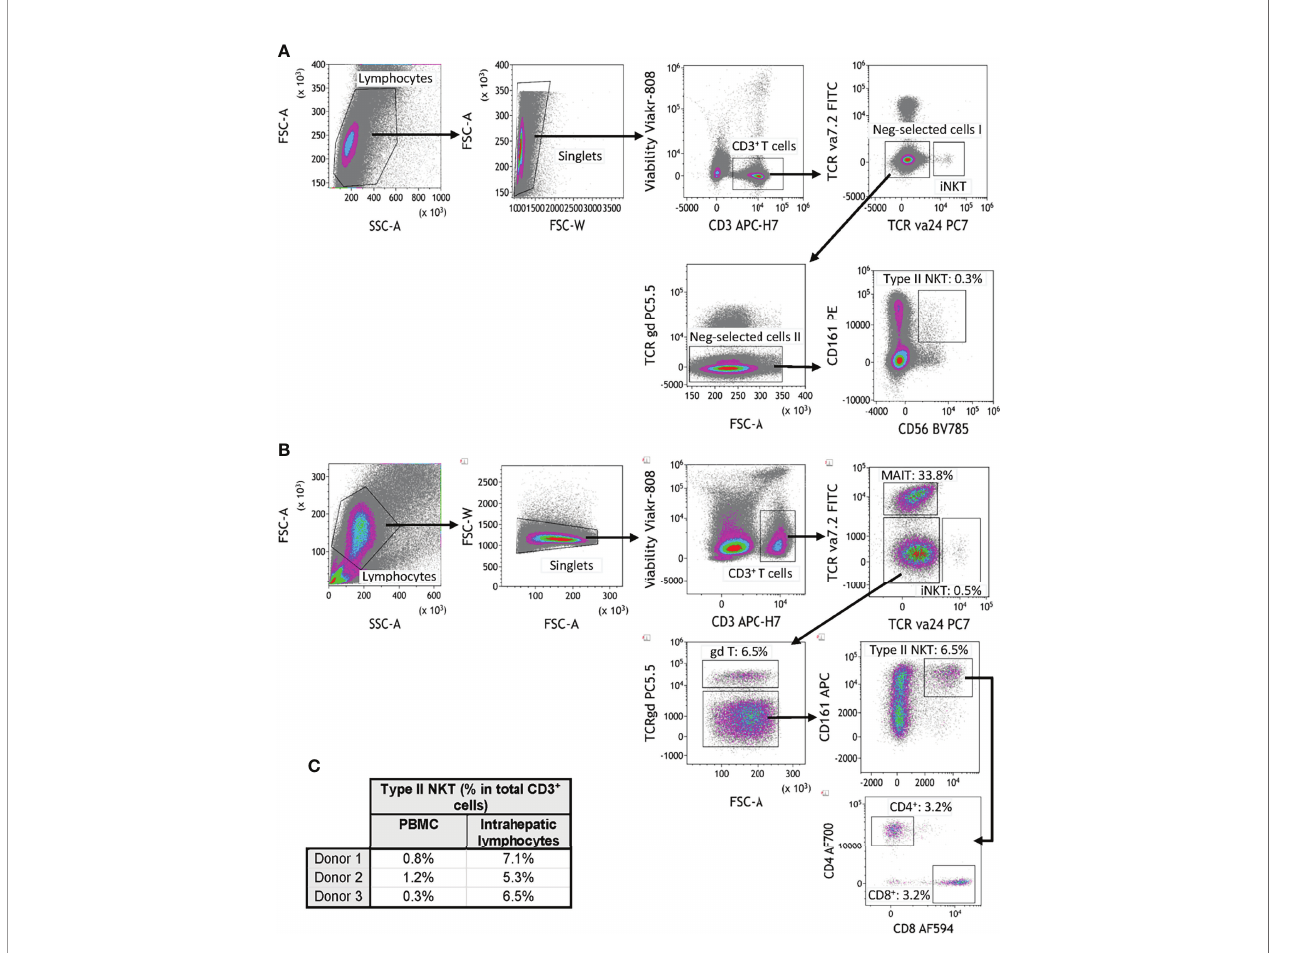
FIGURE 1 | Flow cytometry gating strategy for quanti fi cation of human type II NKT cells. (A) Human T2NKT cells were de fi ned as CD3 + CD56 + CD161 + TCR gd - TCRV a 7.2 - TCRV a 24 - lymphocytes. Gating of human PBMC resulted in a very low frequency of circulating T2NKT cells (0.3% of total CD3 + T cells). (B) Gating of human intrahepatic lymphocytes (IHL) revealed a higher frequency of T2NKT cells in non-steatotic liver (6.5% of total CD3 + T cells). Intrahepatic T2NKT cells could be subdivided into CD4 + and CD8 + cells. (C) Frequency of human T2NKT cells with respect to CD3 + T cells from 3 PBMC and 3 liver samples (steatosis 0%, n = 2; steatosis 15%, n =